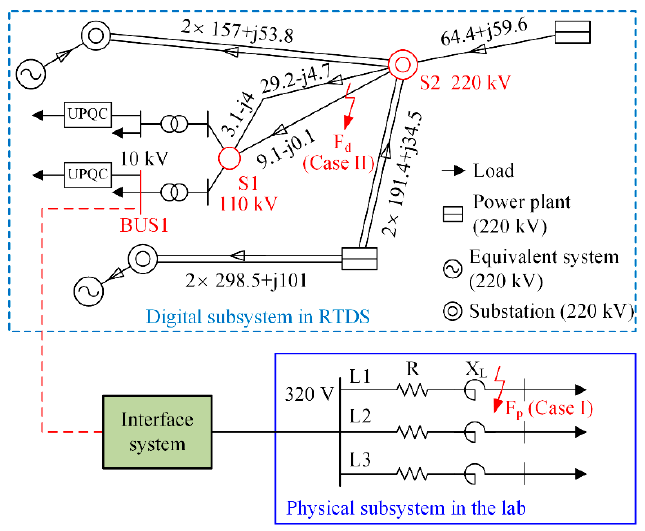
Figure 2. Digital-physical hybrid real-time simulation system used for fault recurrence.